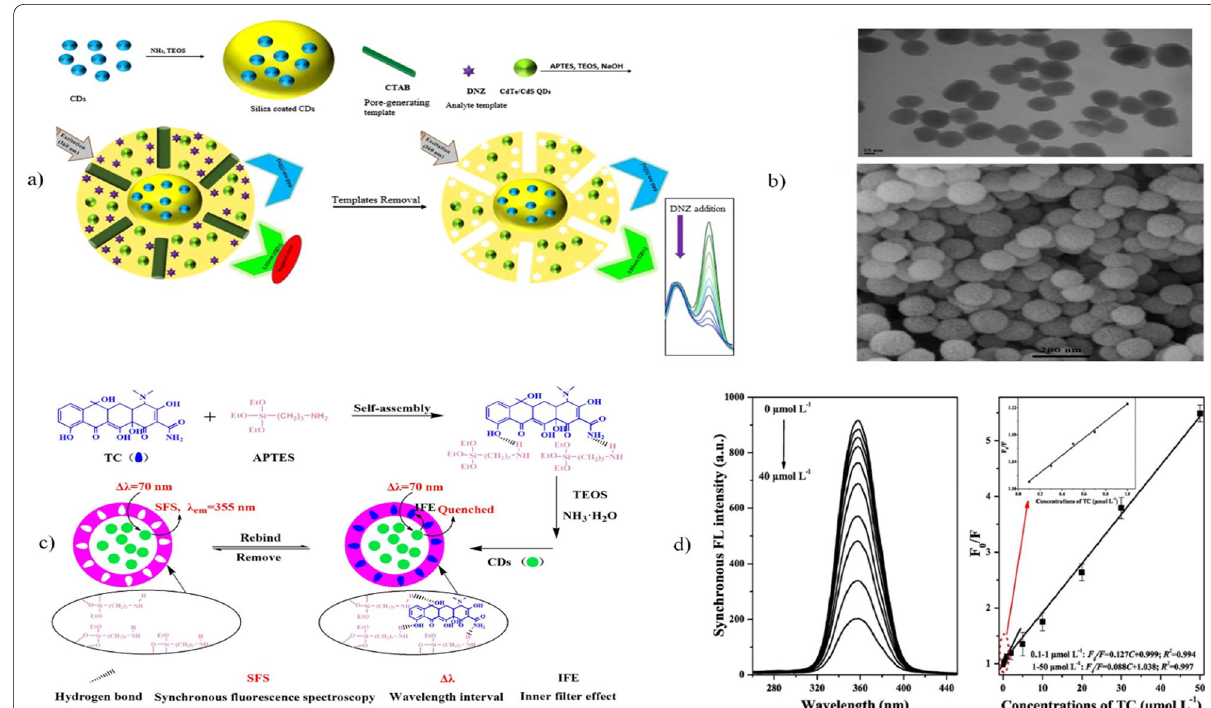
Fig. 1 Representative schemes for the construction and function of CD–silica nanosensors: a Scheme of nanosensor construction and operation for diniconazole detection, b SEM and TEM micrographs of the mMIP@CDsQDs. Adapted with permission from ref. [180] copyright 2017 Elsevier. c Scheme of nanosensor construction and operation for tetracycline detection, d SFS spectra showing the fluorescence intensity behavior as a function of the TC concentration. Adapted with permission from ref. [188] copyright 2017